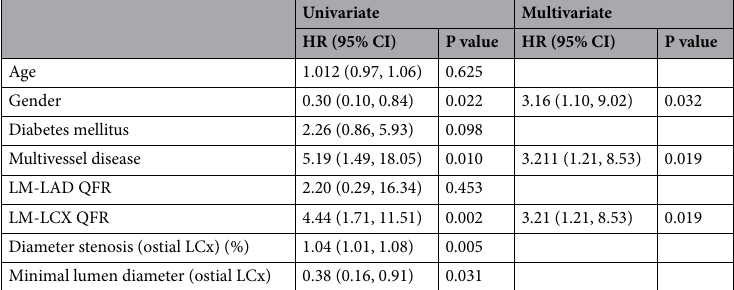
Table 3. Univariate and multivariate cox proportional hazard analyses for 5-year TLF.